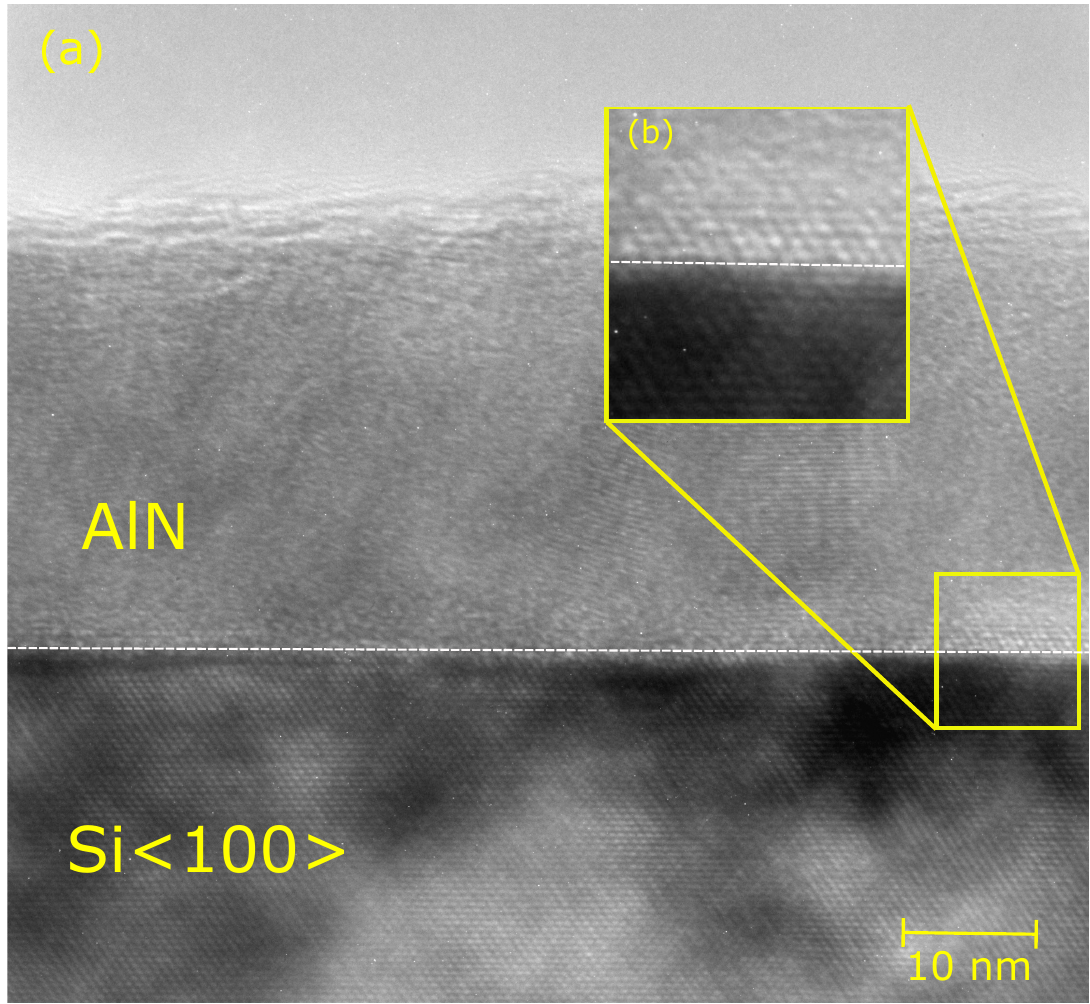
Figure 2. ( a ) TEM cross-section image of 30nm AlN grown on Si<100> with a in situ ALA treatment at plasma power of 200W and 60s; ( b ) Enlarged interface of the Si<100> substrate and AlN of the